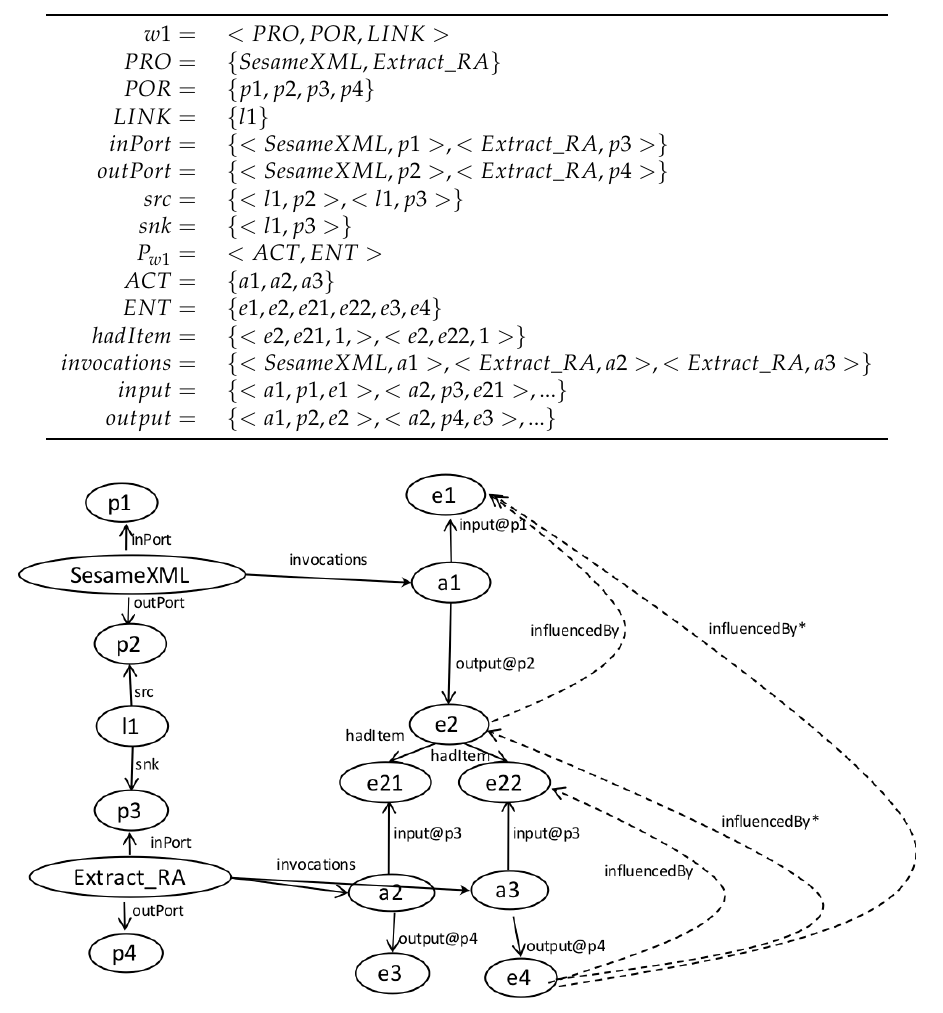
Table 1. Formal specification of an example workflow w 1 and its provenance P w 1 .